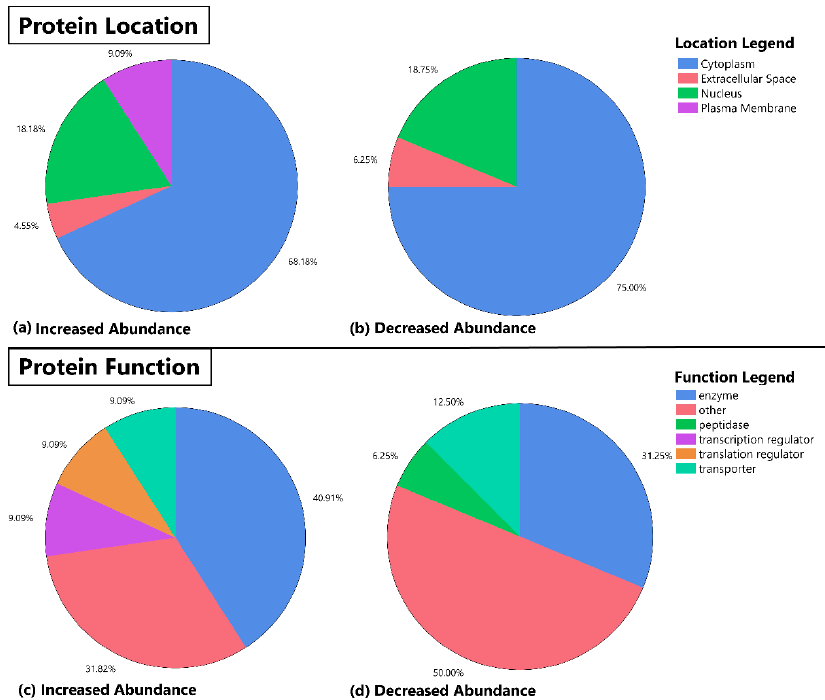
Figure 1. Pie chart representation of protein location and function for identified protein abundance differences between patients on atypical antipsychotics (AAP) and mood stabilizers. This figure depicts the location and function (as determined by the Molecule Module of Ingenuity Pathway Analysis Software) of protein abundancies that were determined to be significantly different in the skeletal muscle of AAP-treated subjects versus mood stabilizer-treated subjects. The top half of the panel depicts protein location ( a , b ) and the bottom half of the panel shows the distribution of annotated function for each identified protein ( c , d ). The increased abundance and decreased abundance refer to increases or decreases in the AAP group relative to the mood stabilizer group. In-silico pathway analysis of significantly altered protein abundance sites revealed an enrichment of 107 pathways, with 21 below an FDR p of 0.1. The most significant enrich- ment was in p70S6K signaling and cell cycle pathways. A list of the top pathways is pre- sented in Table 3. Table 3. Enriched pathways based on the 40 proteins with a significant difference between AAP and mood stabilizers using Ingenuity Pathway Analysis.